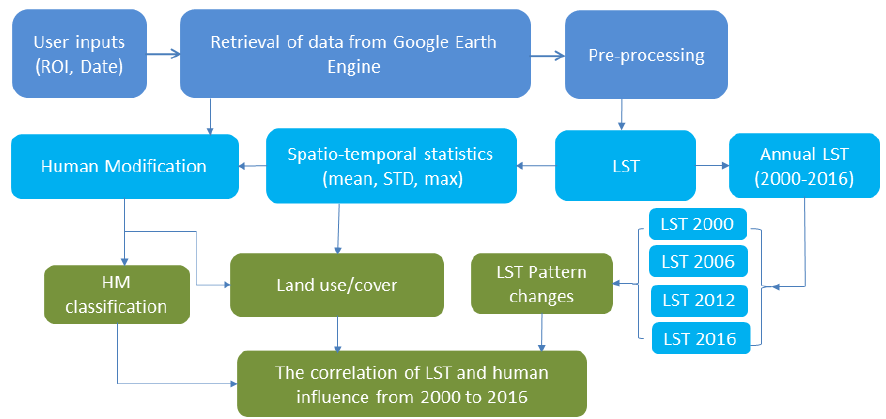
Figure 2. Flow diagram of the main steps of analysis. The steps in blue outline the retrieval LST dynamics and human modification index within GEE archives. The steps highlighted in green outline the analysis of correlation between LST and human modification and land use / cover in a standard desktop GIS platform.